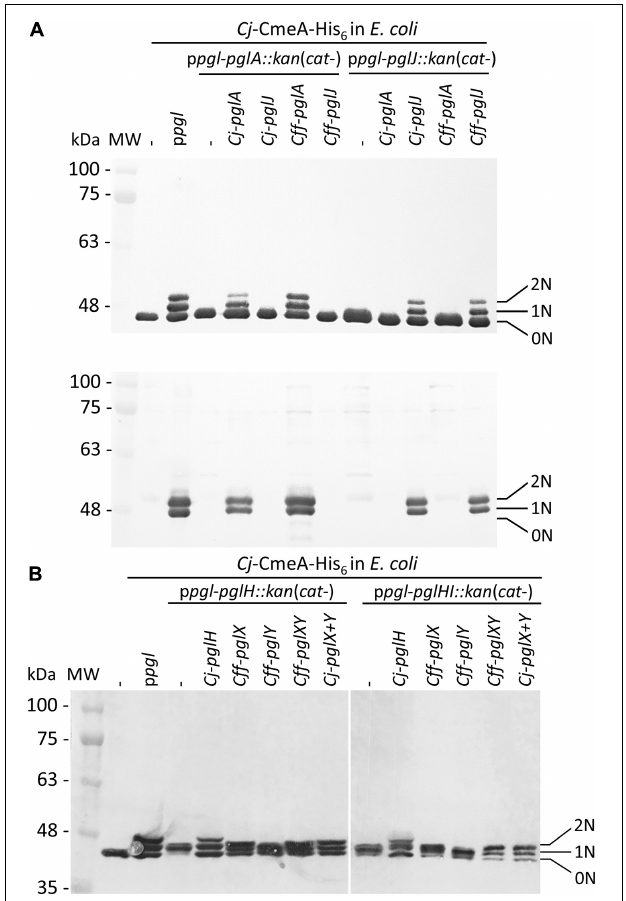
FIGURE 5 | Functional analysis of Cff -Pgl pathway glycosyltransferases (GTases) in the heterologous E. coli glycosylation system. The GTase-activities of (A) PglA and PglJ were analyzed in western blots of Cj- CmeA-His 6 with His 6 -tag antibodies (upper panel) and Cj- N-glycan specific (R1) antibodies (lower panel). (B) PglX and PglY activities were analyzed with His 6 -tag specific antibodies in western blots of CmeA-His 6 used as the glycan acceptor to determine N-glycosylation activities. Whole cell extracts (5 µ g) of E. coli CLM24 expressing the indicated gene/plasmid combinations are indicated above each lane. Non-, mono-, and di-glycosylated CmeA-His 6 proteins are labeled as 0N, 1N, and 2N, respectively. Molecular weight markers (MW) in kDa are indicated on the